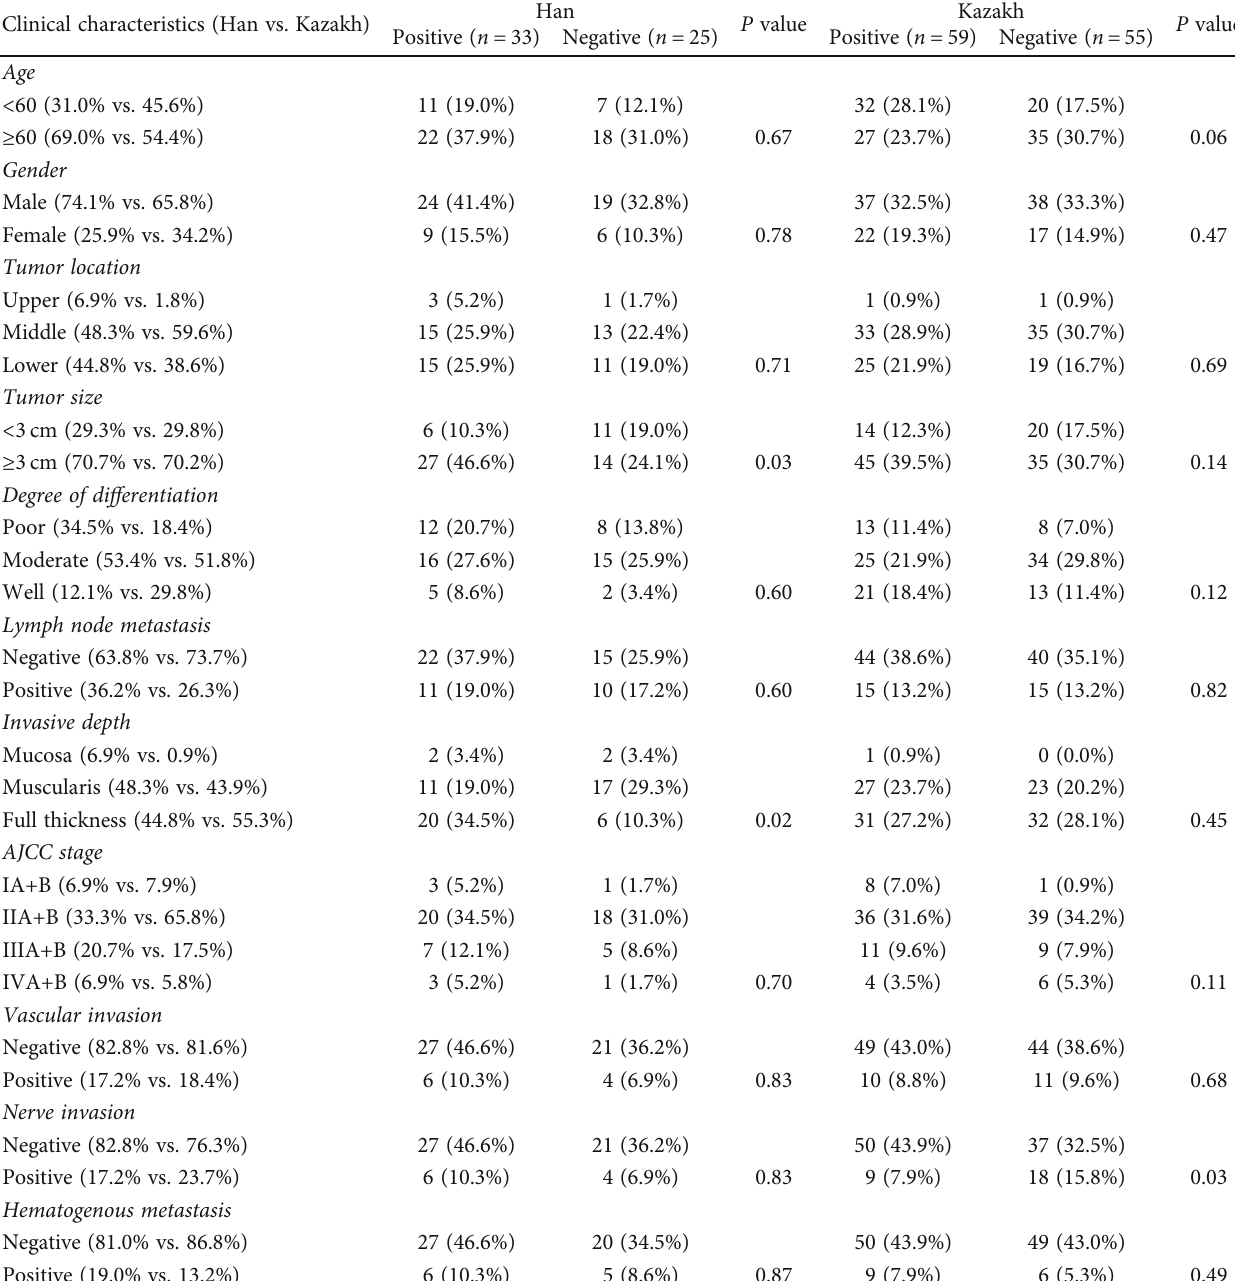
Table 2: The expression of MACC1 and its relationship with clinicopathological parameters in Han and Kazakh patients of ESCC. Clinical characteristics (Han vs. Kazakh)